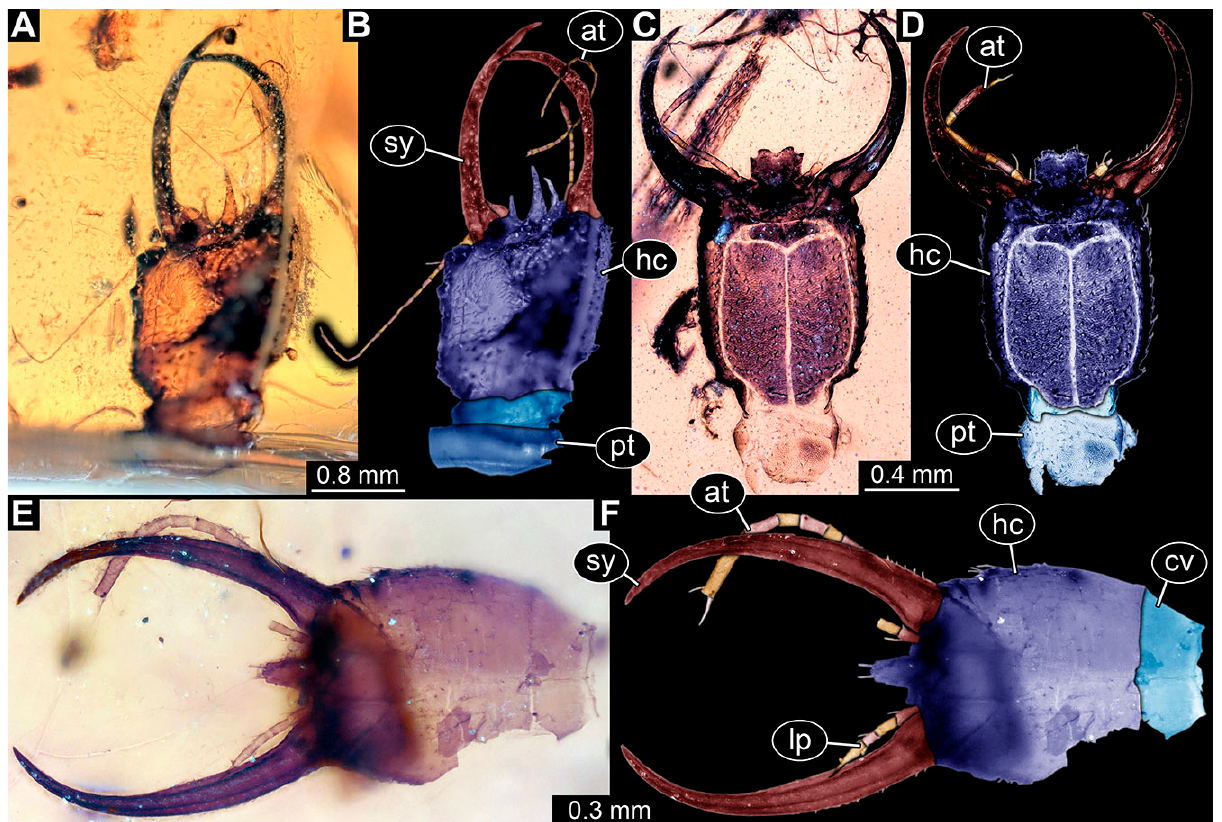
Figure 14. Specimens in Myanmar amber. ( A , B ) Specimen 74 (PED 1049). ( A ) Head capsule, dorsal view. ( B ) Head capsule, dorsal view, colour-marked. ( C , D ) Specimen 83 (PED 1846). ( C ) Head capsule, ventral view. ( D ) Head capsule, ventral view, colour-marked. ( E , F ) Specimen 82 (PED 1831). ( E ) Head capsule, ventral view. ( F ) Head capsule, ventral view, colour-marked. Abbreviations: at = antenna; hc = head capsule; lp = labial palp; pt = prothorax; sy = stylet.